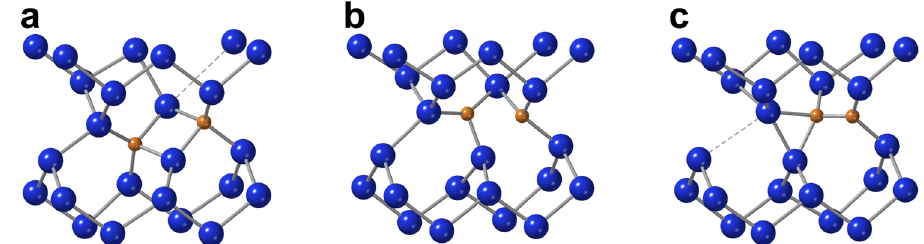
Fig. 6 | The path ofthe transformationofthe A - con fi gurationintothe C - con fi guration(c.f.Fig. 5). Dashed linesindicate bonds in the breaking/forming,and are just guides to the eye. a The local minimum. b The saddle point. c The stationary